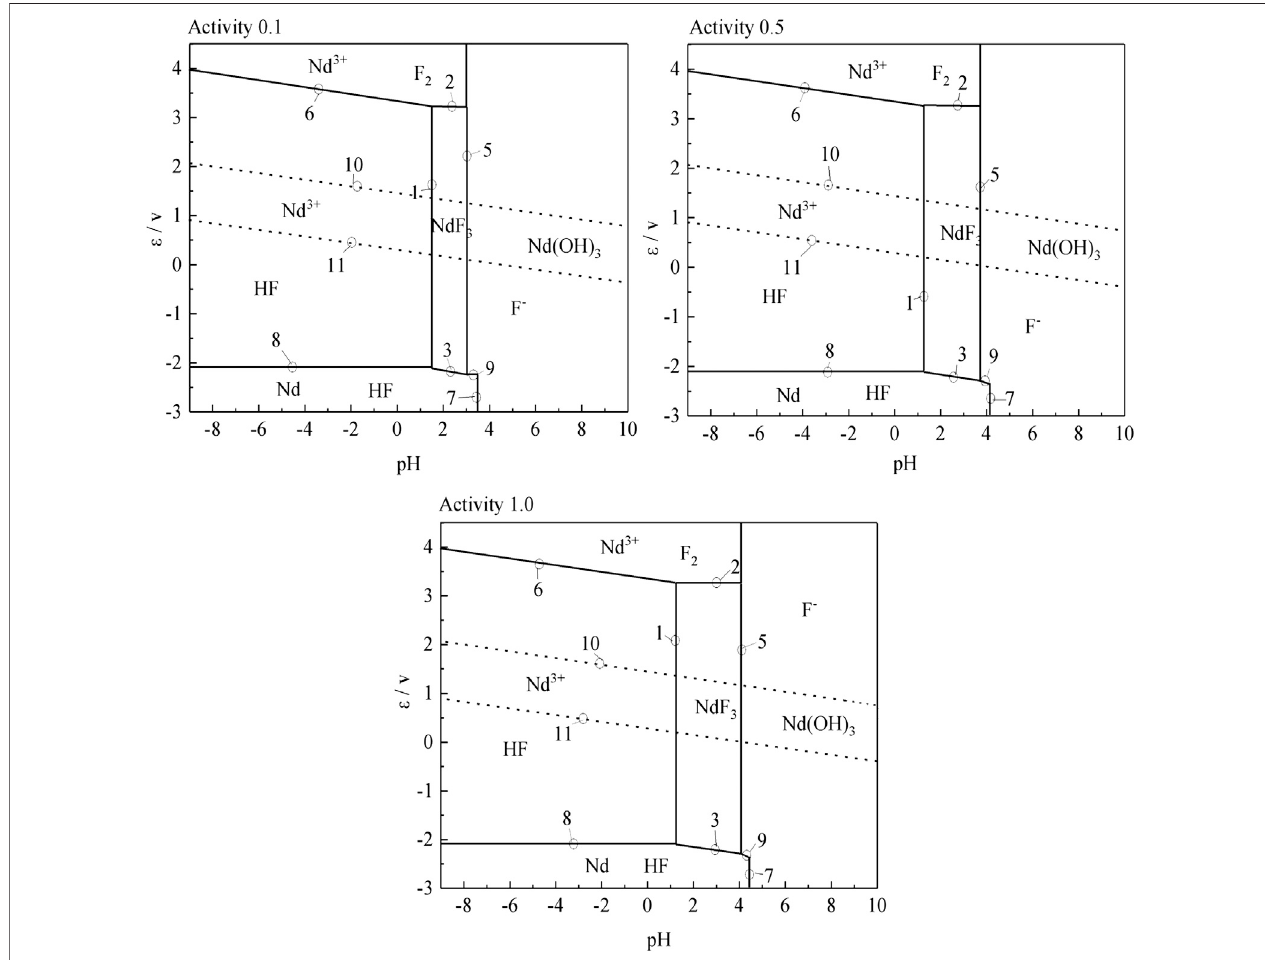
FIGURE 5 | ε -pH diagram of the Nd-F-H 2 O system with different activities at 603 K